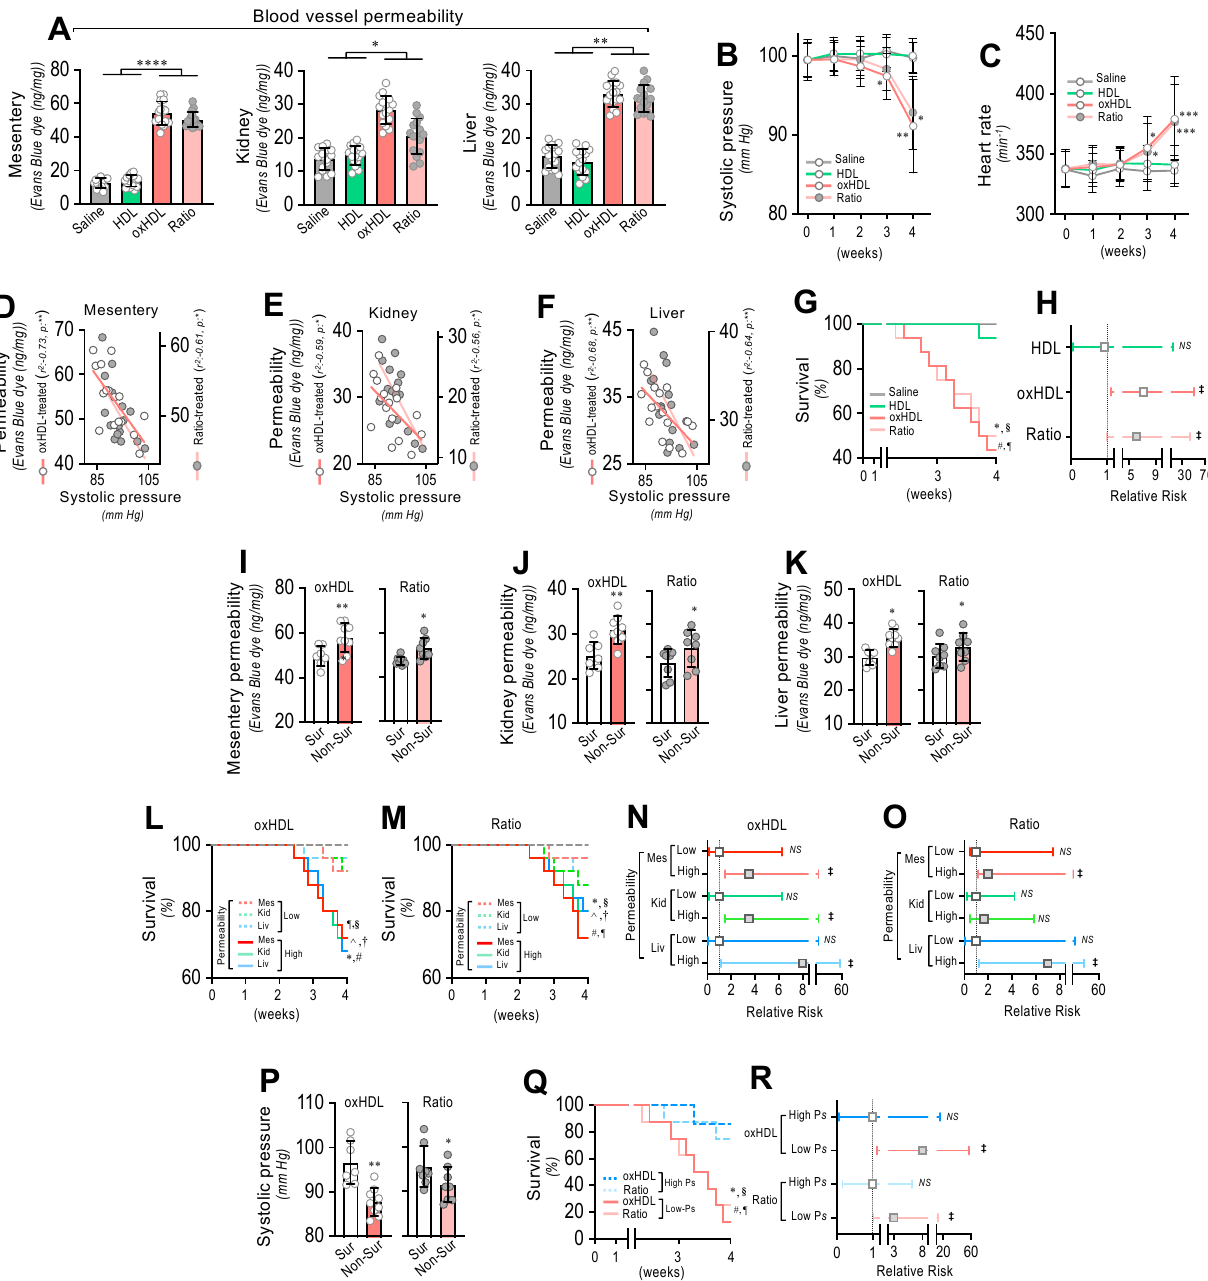
Figure 5. In vivo oxHDL administration induces blood vessel hyperpermeability, hypotension, increased risk of death and decreased survival in rats. ( A ) After saline, HDL, oxHDL, and ox- HDL/HDL ratio treatments, mesentery, kidney, and liver were harvested and processed for EBD extraction to determine blood vessel hyperpermeability. EBD content was normalized to total sample weight (N = 16). ( B , C ) Systolic pressure ( B ) and heart rate ( C ) recording in saline-, HDL-, oxHDL-, and oxHDL/HDL ratio-treated rats at 1, 2, 3, and 4 weeks. (N = 16). ( D – F ) Correlation analyses between systolic pressure with mesentery ( D ), kidney ( E ), and liver ( F ) permeability in oxHDL- and oxHDL/HDL ratio-treated rats. ( G ). Survival (Kaplan–Meier) curves comparing saline-, HDL-, oxHDL-, and oxHDL/HDL ratio-treated rats. * and #, p = 0.0003 (log-rank (Mantel–Cox) test) when comparing oxHDL- and oxHDL/HDL ratio-treated rats versus saline-treated (*) and HDL-treated (#) rats. § and ¶, p = 0.001 (Gehan–Breslow–Wilcoxon test) when comparing oxHDL- and oxHDL/HDL ratio-treated rats versus saline-treated (¶) and HDL-treated (§) rats. (N = 16). ( H ).